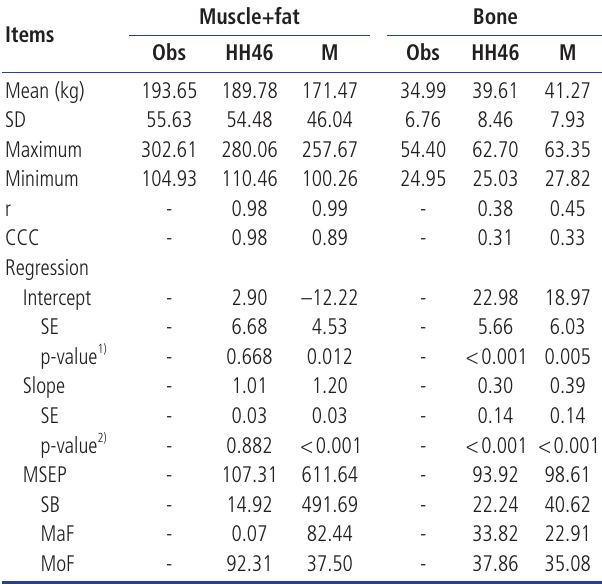
Table 4. Descriptive statistic of the relationships between the observed and predicted carcass physical composition values Muscle+fat Items